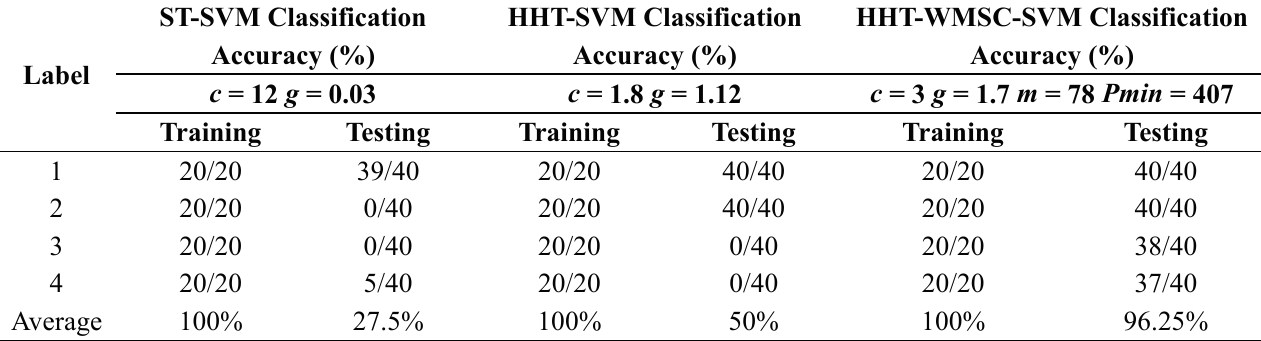
Table 6. Bearing fault detection results obtained by the ST-SVM, HHT-SVM and HHT-WMSC-SVM models for dataset